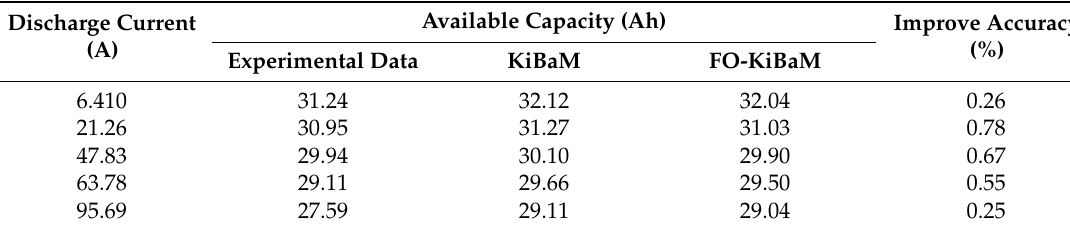
Figure 11. Battery capacity variance at different C-rates (local magnification). Table 3. Prediction results of the battery’s available capacity at different C-rates.